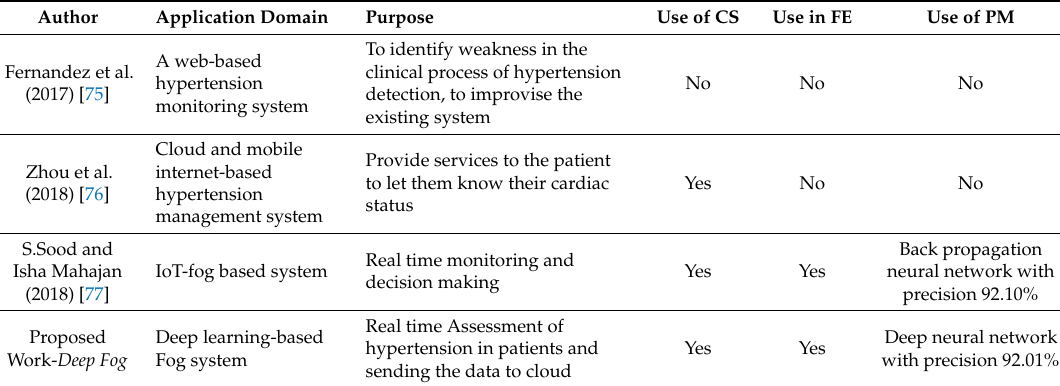
Table 10. Comparative analysis of Hypertension risk